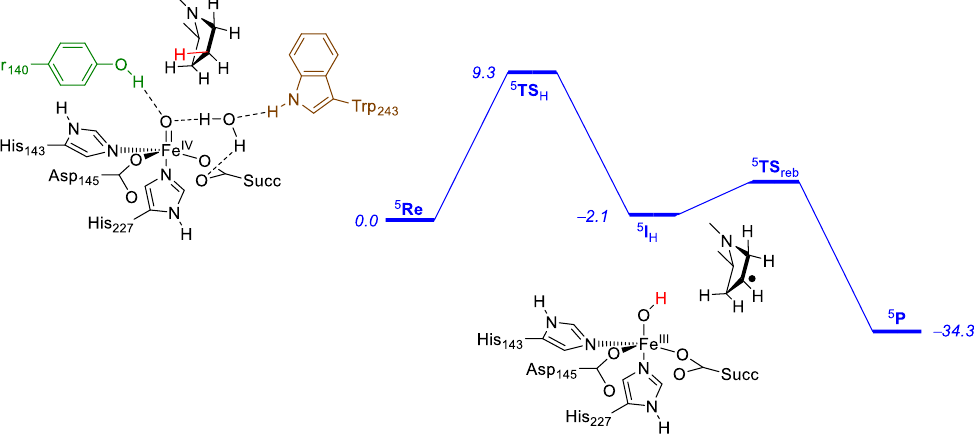
Figure 13. QM/MM-optimized potential energy landscape (UB3LYP/SV(P):Charmm) for proline hydroxylation at the C 4 -position. Energies contain zero-point corrections and are in kcal mol − 1 . Key amino acids and functional groups highlighted.